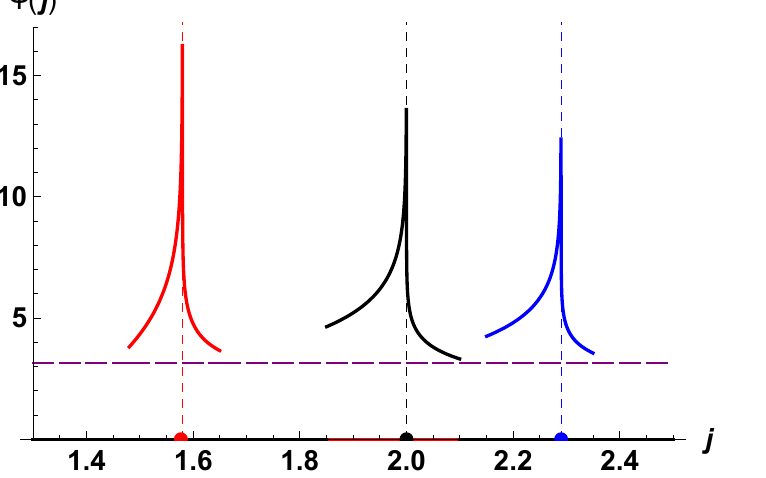
Figure 5. Comparison of Ψ ( j , ω ) for black hole spin-values ω = − 1 (blue). Horizontal dashed line shows the Newtonian periastron Ψ N = π .